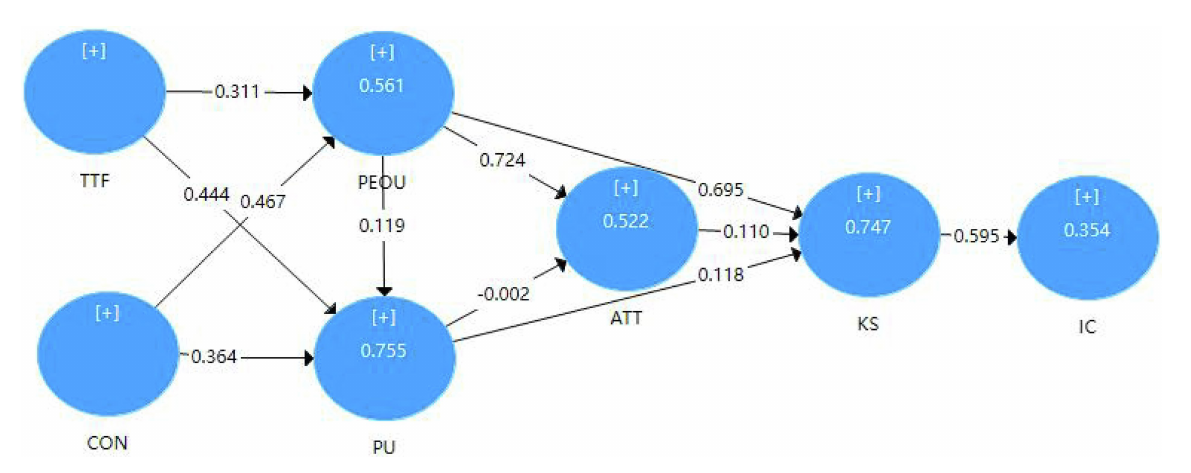
FIGURE 5 PLS results of the research